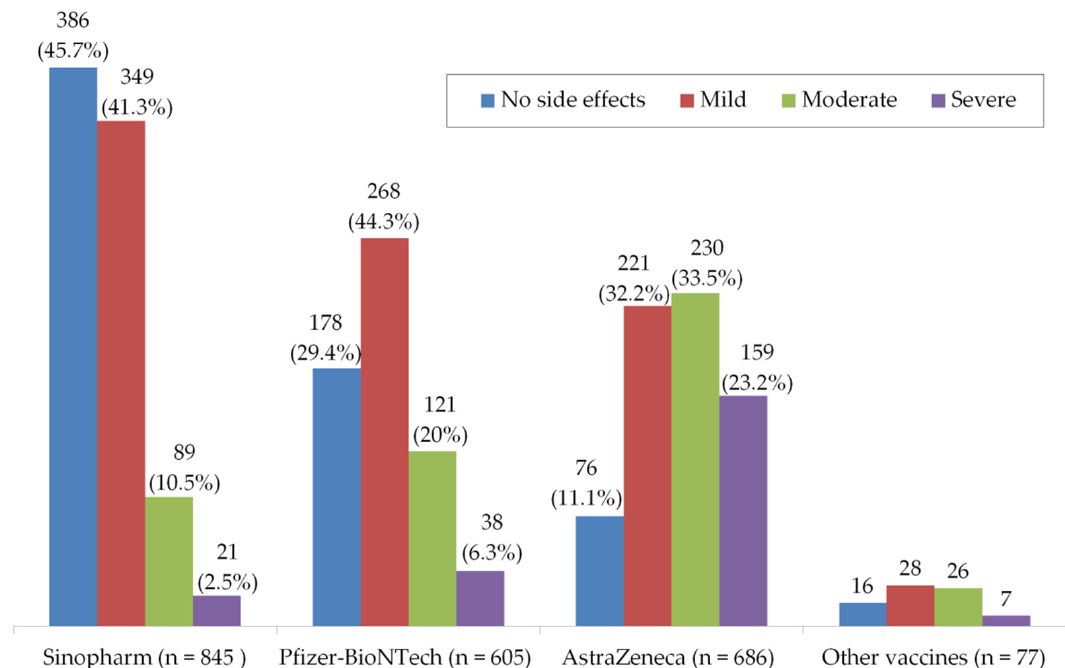
Figure 5. Severity of side effects based on the types of COVID-19 vaccine. Other vaccines are Sputnik V, Moderna, Covaxin, and Johnson & Johnson. Table 4. Association of the side effects with the possibility of COVID-19 infection after receiving both